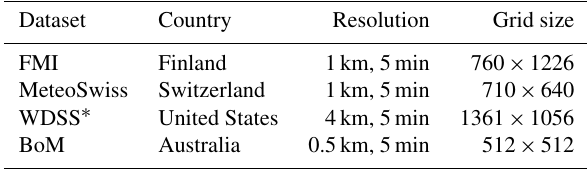
Table 4. Overview of the radar quantitative precipitation estimation (QPE) composites that have been used to evaluate pysteps. The grid size is given as the number of pixels in the x and y